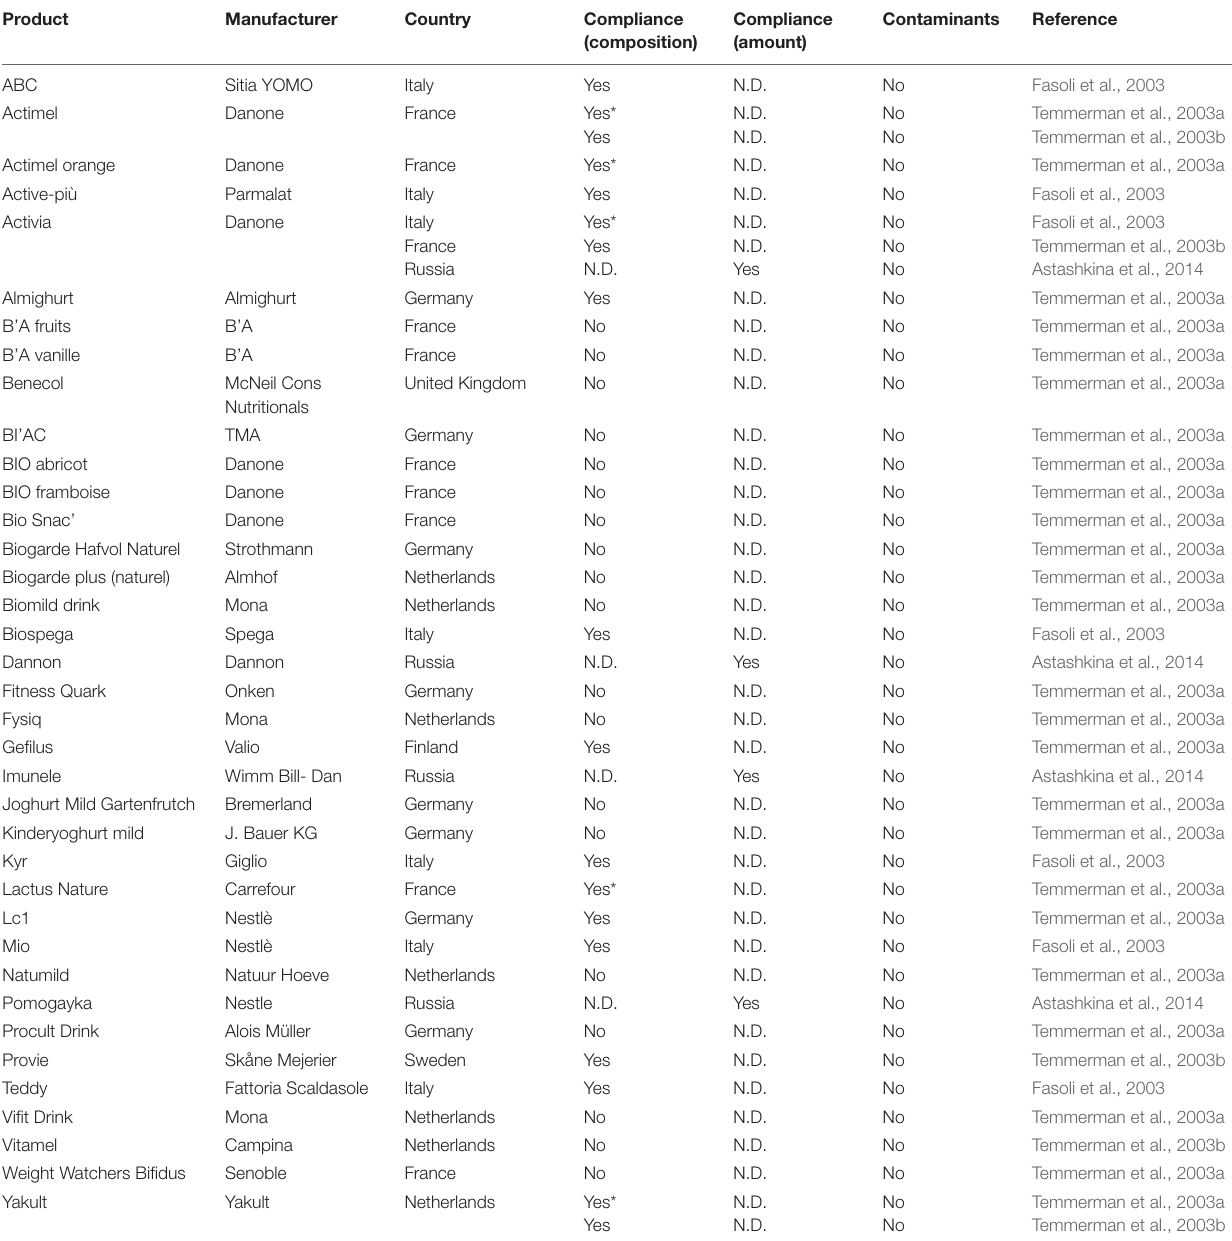
TABLE 3 | Compliance with the label claims of probiotic functional foods marketed worldwide: focus on the microbial composition, amount of living cells, and presence of contaminant microorganisms.